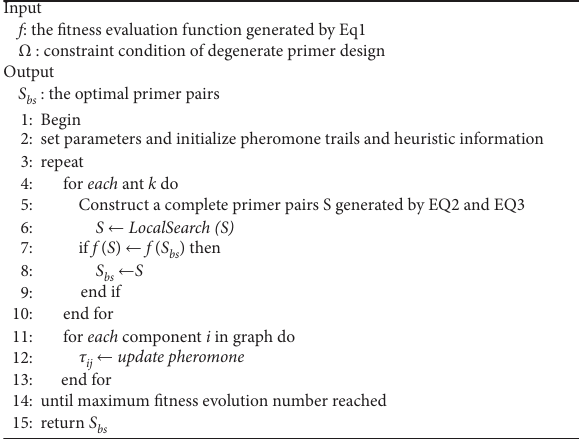
Figure 2: Simplifed model of construction Algorithm ACOH for Degenerate Primer Design pseudo- Algorithm ACOH for Degenerate Primer Design